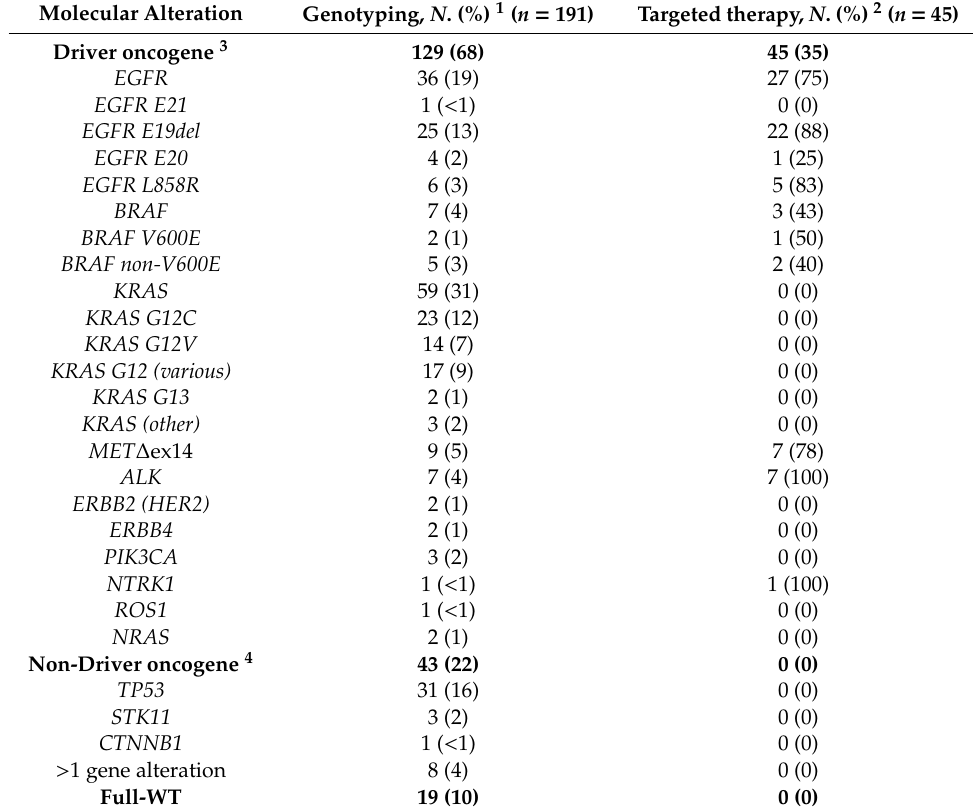
Table 2. Genes with mutational or structural changes identified and targeted treatments received for patients with full genotyping ( n =